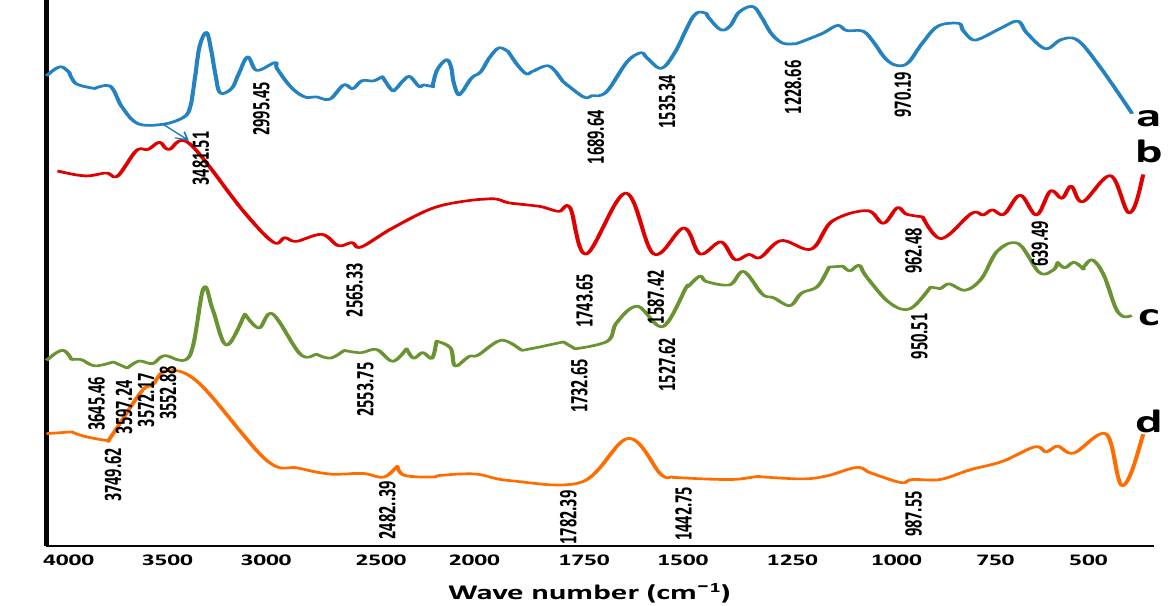
Figure 2. FTIR spectra of (a) BSG (b) captopril (c) BSG–co–poly (AA) unloaded hydrogels. (d) BSG–co–poly (AA) loaded